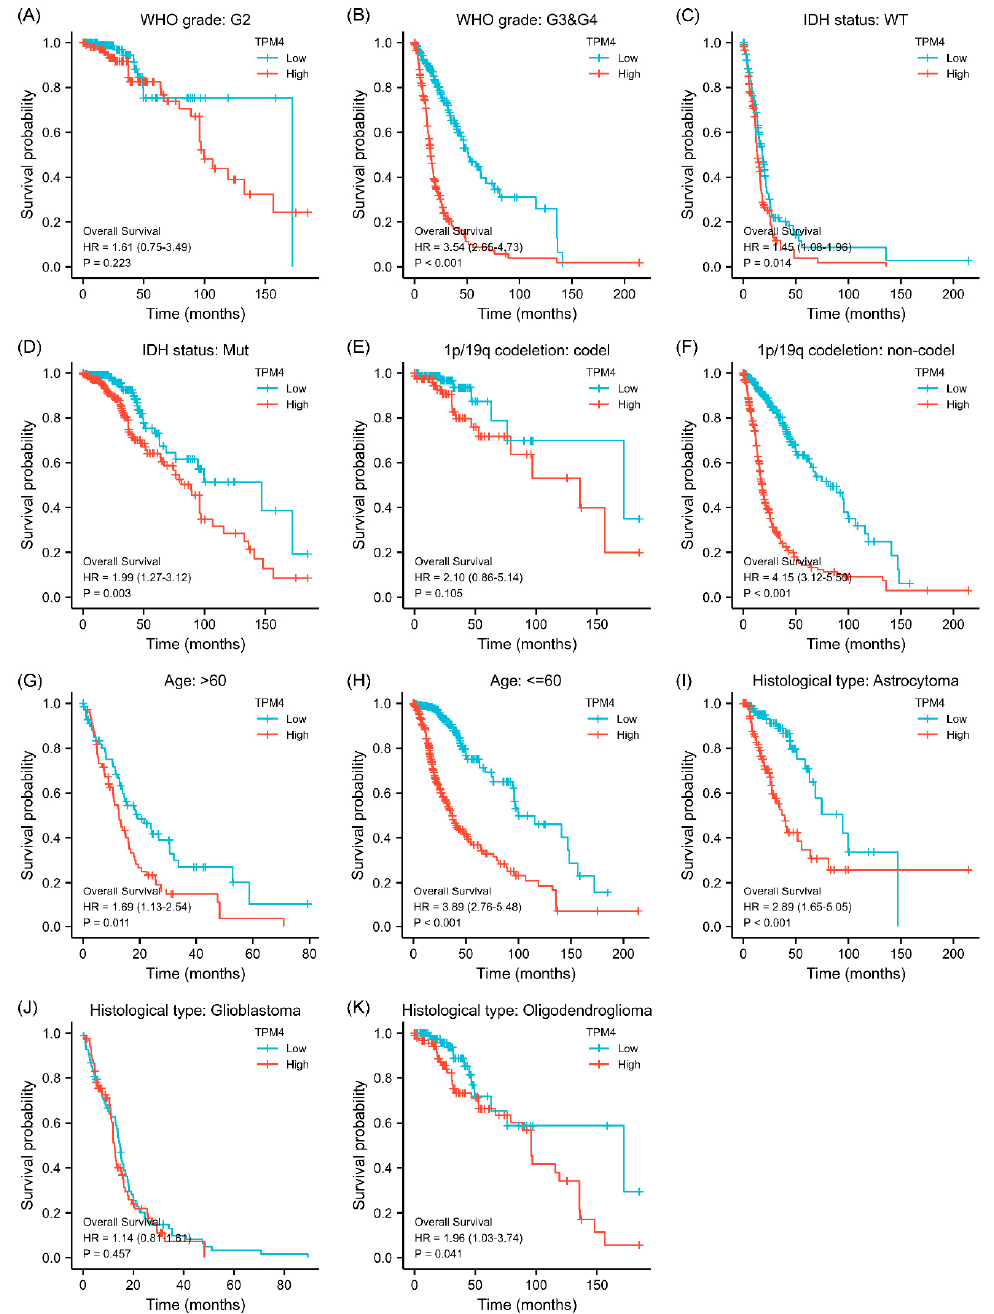
Figure 4. Subgroup survival analyses for the association between TPM4 expression and clinical characteristics. ( A , B ) Correlations between TPM4 expression and WHO grade. ( C , D ) Correlations between TPM4 expressions and IDH status. ( E , F ) Correlations between TPM4 expression and 1p/19q status. ( G , H ) Correlations between TPM4 expression and age. ( I – K ) Correlations between TPM4 expression and histological type.